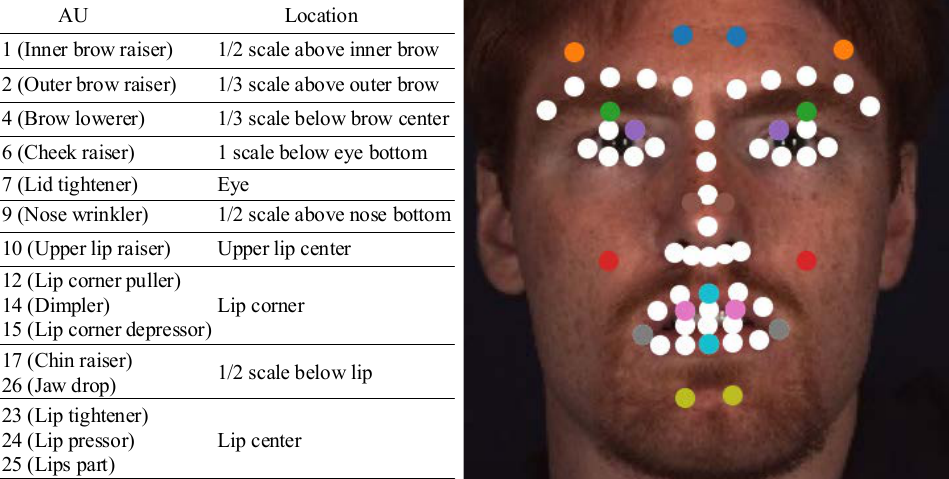
Figure 2. The overview of our PAA framework. An input image firstly goes through two hierarchical and multi-scale region layers [3,10], each of which is followed by a max-pooling layer. Then, m branches are used to predict AU occurrence probabilities, in which the learned attention map (cid:99) M element-wise multiplied by the predefined mask M i to obtain the new attention map (cid:99) M i -th AU. We overlay the attention maps as well as the masks on the input image for a better view. “ (cid:63) ” refers to element-wise multiplication. The expression c × l × l refers to the layer dimensions are c , l , and l , respectively.